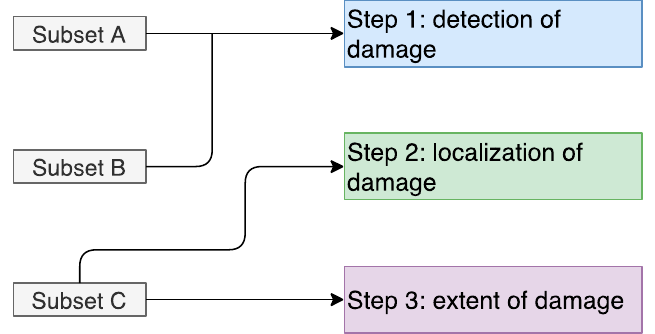
Figure 2. Scheme of the datasets adopted for the training of the neural networks for each step of the structural